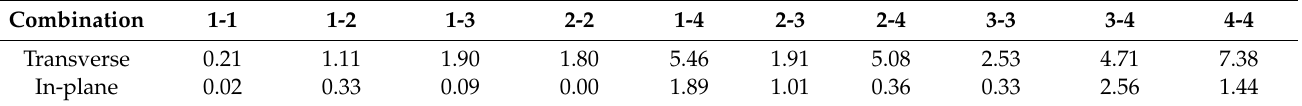
Table 8. Maximum representation errors of the 10 combinations for the fully clamped